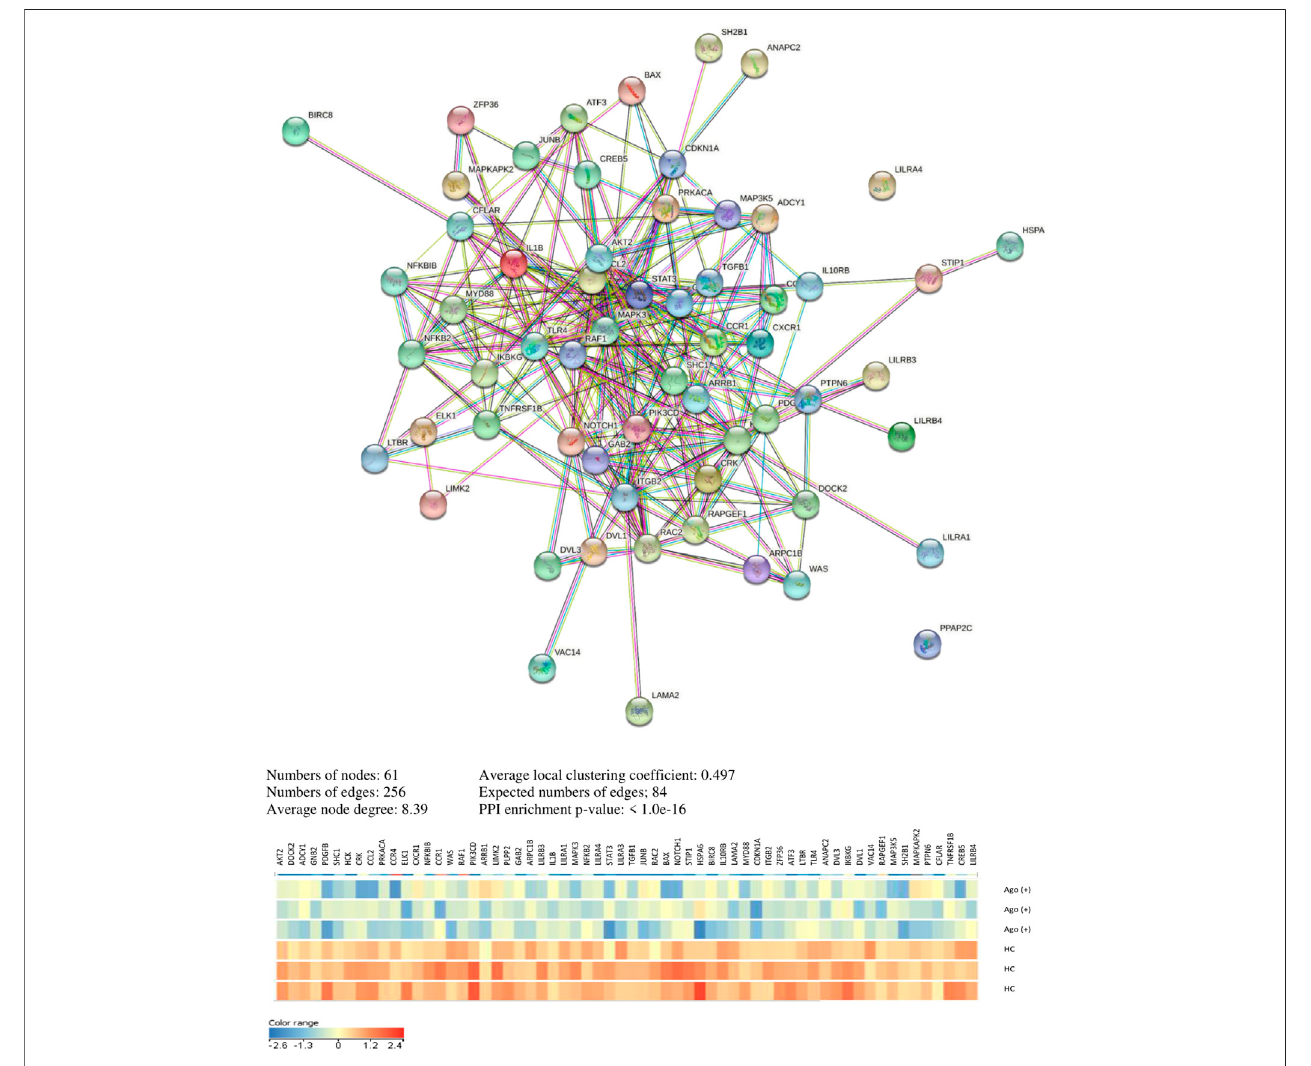
FIGURE 5 | Interaction network of unique genes for agomelatine